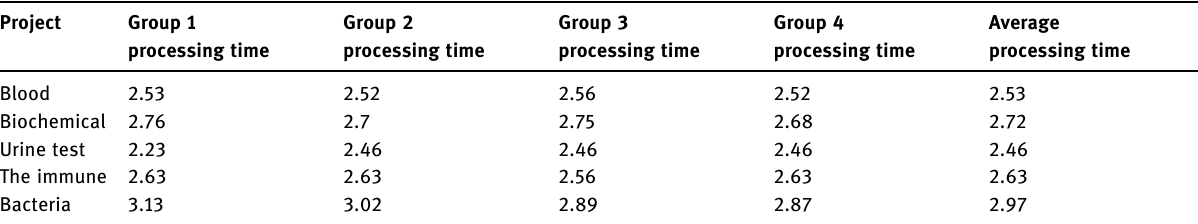
Table 2: Time test result table of quality control chart issuance